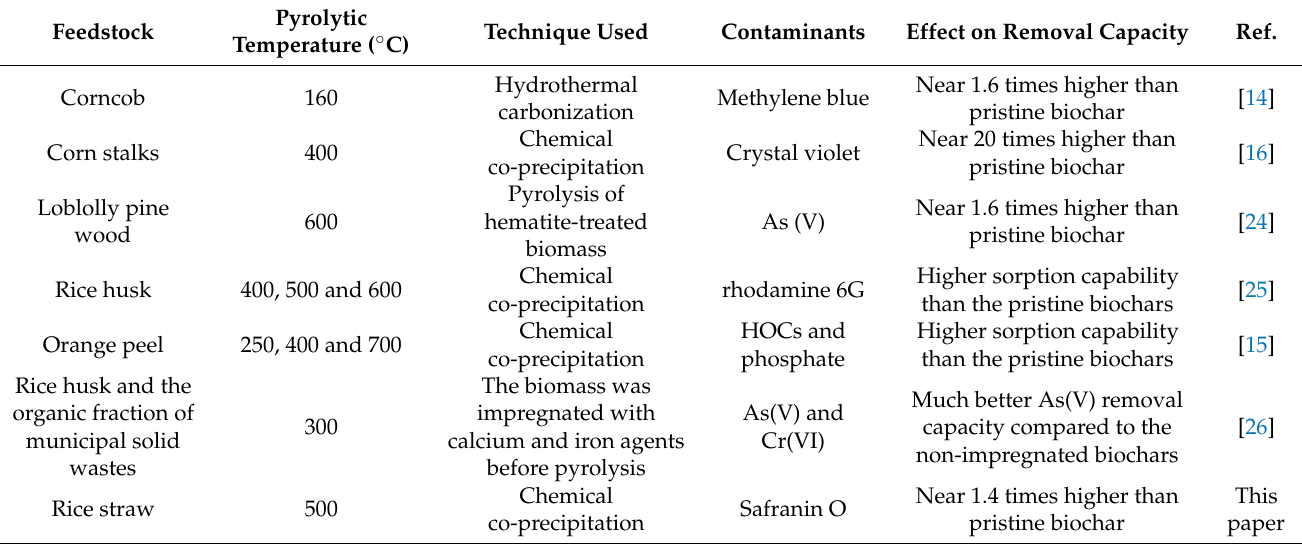
Table 3. Comparison of previous studies on the removal capacity of various contaminants between magnetic biochar and pristine